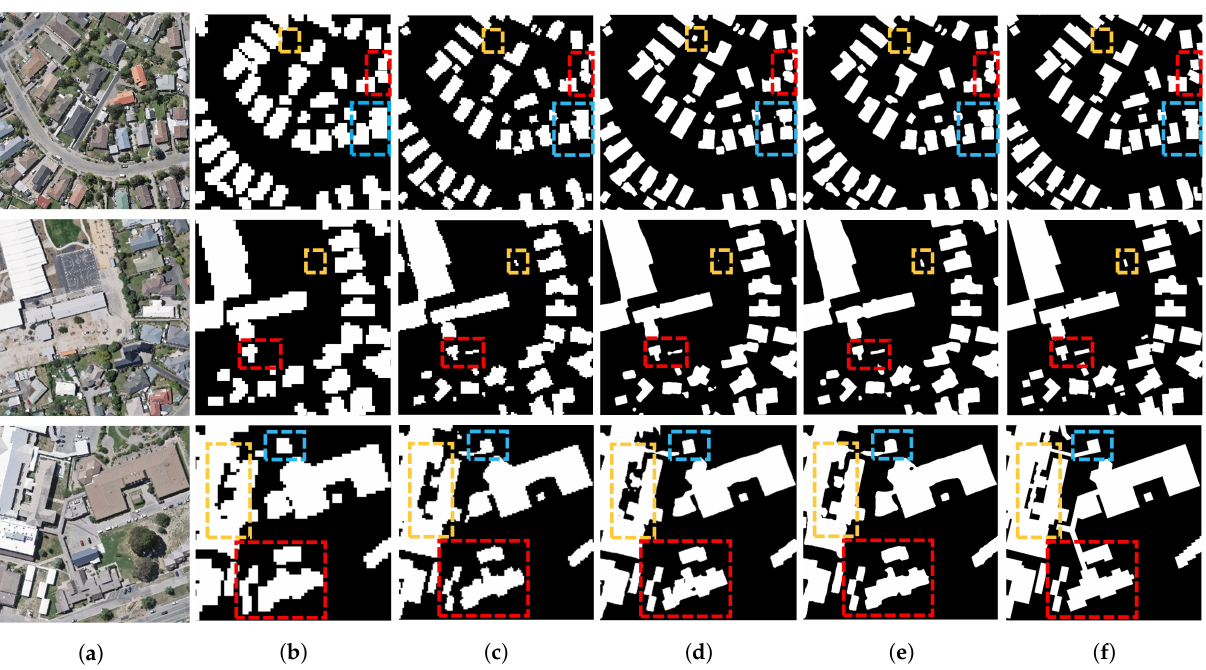
Figure 9. Visualization results of ablation experiments. ( a ) Original image; ( b ) the output of BaseNet (ResNet-101); ( c ) the output of BaseNet + SFM; ( d ) the output of BaseNet + SFM + FEM; ( e ) the output of CFENet (BaseNet + SFM + FEM + FDM); ( f ) ground truth. The experimental results in the box show areas where the contrast effect is more